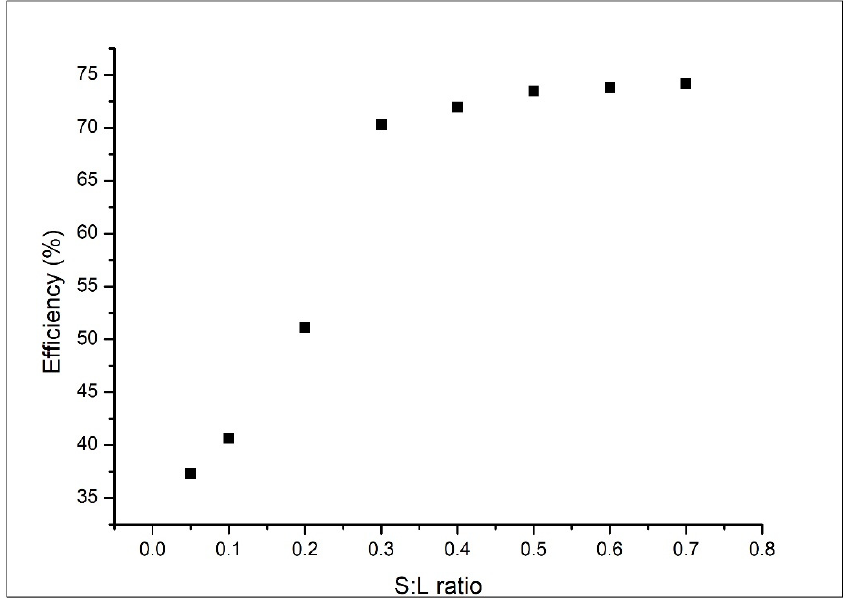
Figure 7. Influence of solid (S):liquid (L) ratio on adsorption process efficiency.